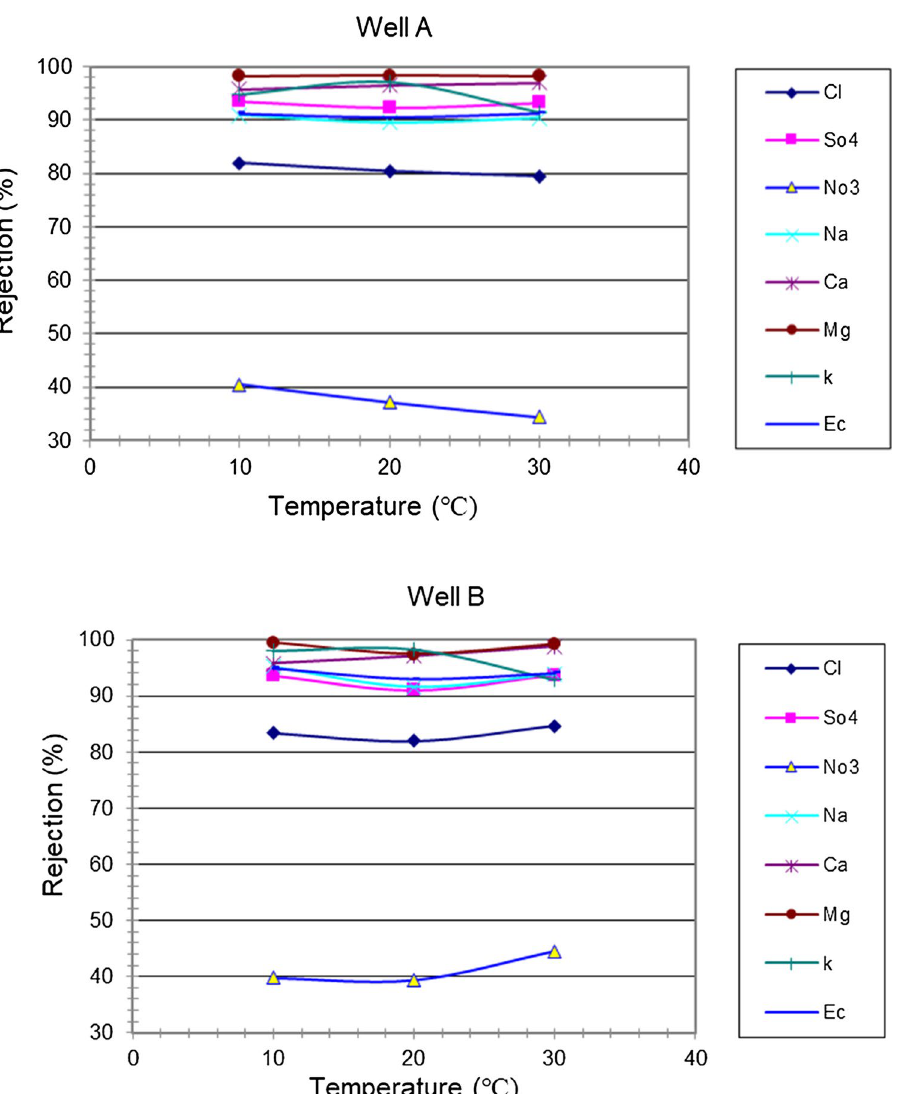
Fig. 7 Rejection rate of ions versus temperature (pressure: 12 bar)